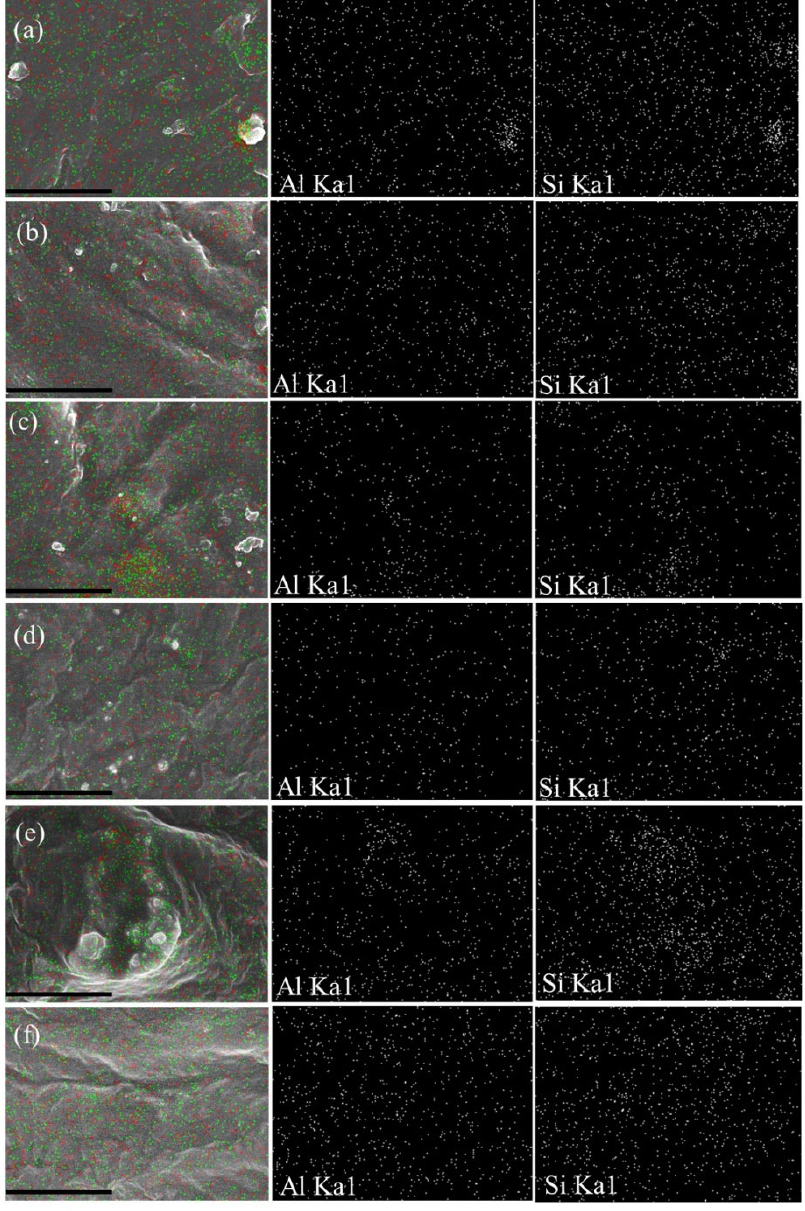
Figure 4. FE − SEM − EDS mapping at × 5000 (scale bar = 10 µ m) of silicon (Si) atoms (green) and aluminum (Al) atoms (red) to indicate HNT distribution in PEO − 20%LiCF 3 SO 3 − 5%HNT of ( a ) Non − US, ( b ) US 5 min, ( c ) US 10 min, ( d ) US 15 min, ( e ) US 30 min and ( f ) US 60